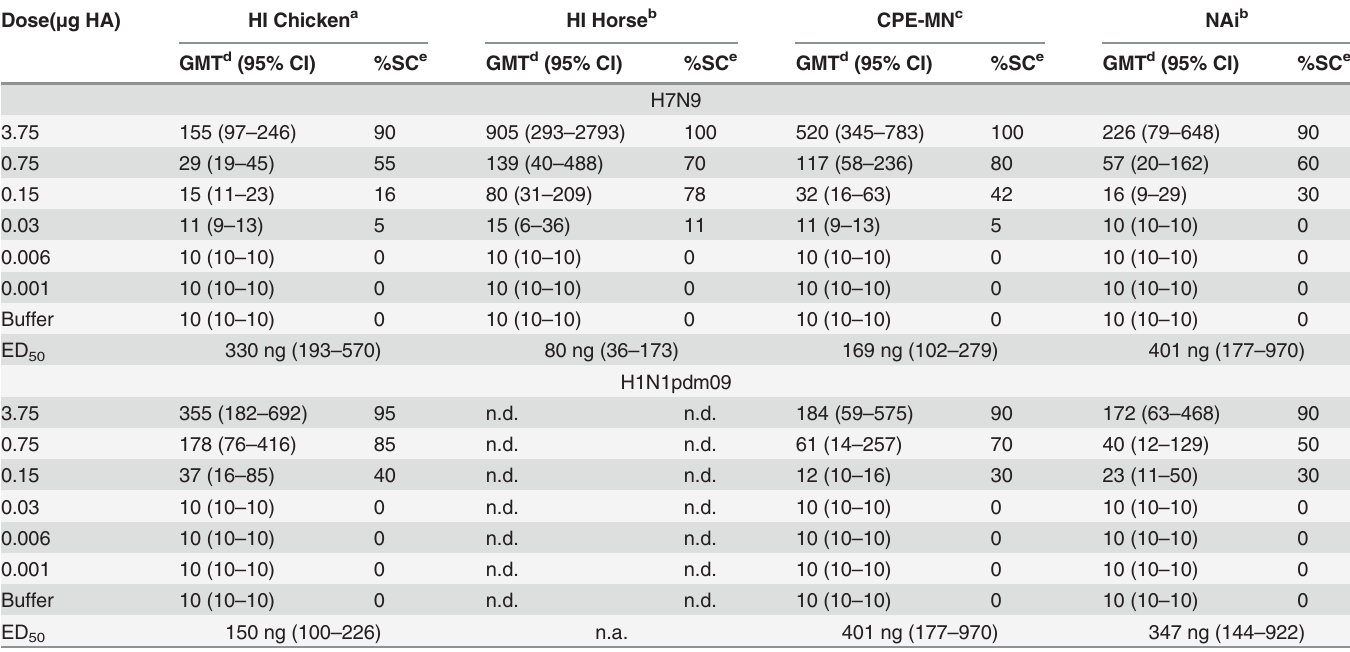
Table 3. HA and NA antibody responses induced by H7N9 and H1N1pdm09 vaccines in DBA/2J mice. Dose( μ g